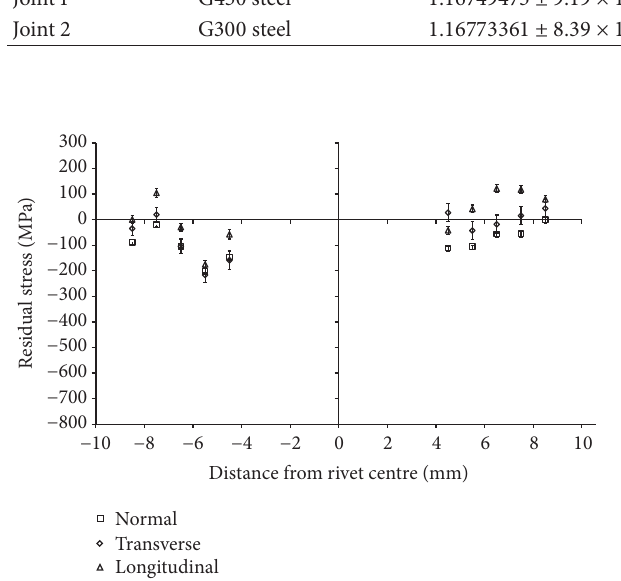
Figure 7: Distribution of residual in top sheet of joint I along BB line as depicted in Figure